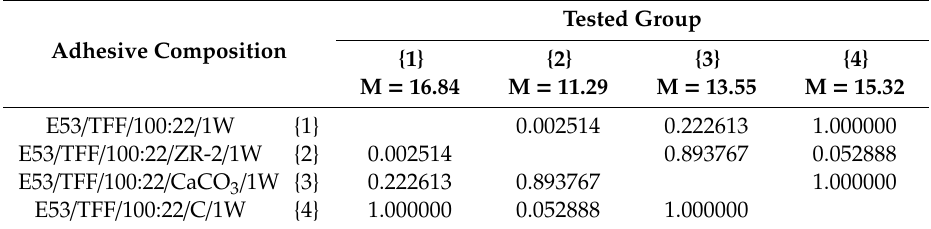
Table 8. The Kruskal–Wallis rank test results of the strength of the adhesive compositions from the E53 / TFF / 1 week